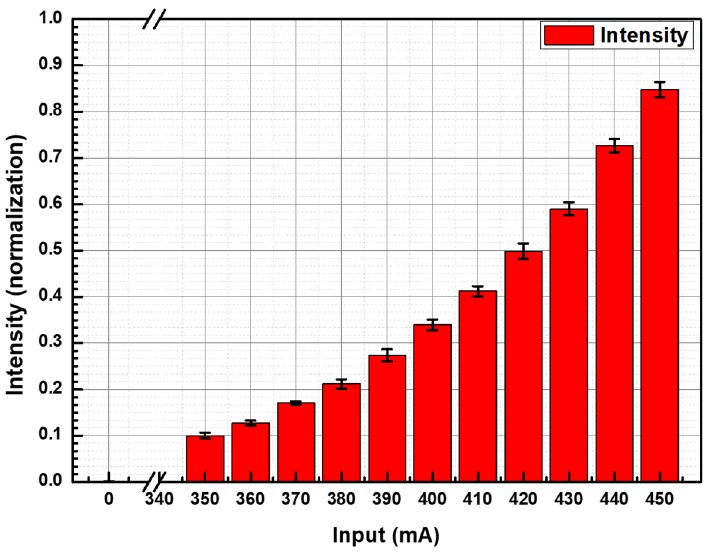
Figure 4. Intensity of the output pulse according to the magnitude of the current input to the OA.